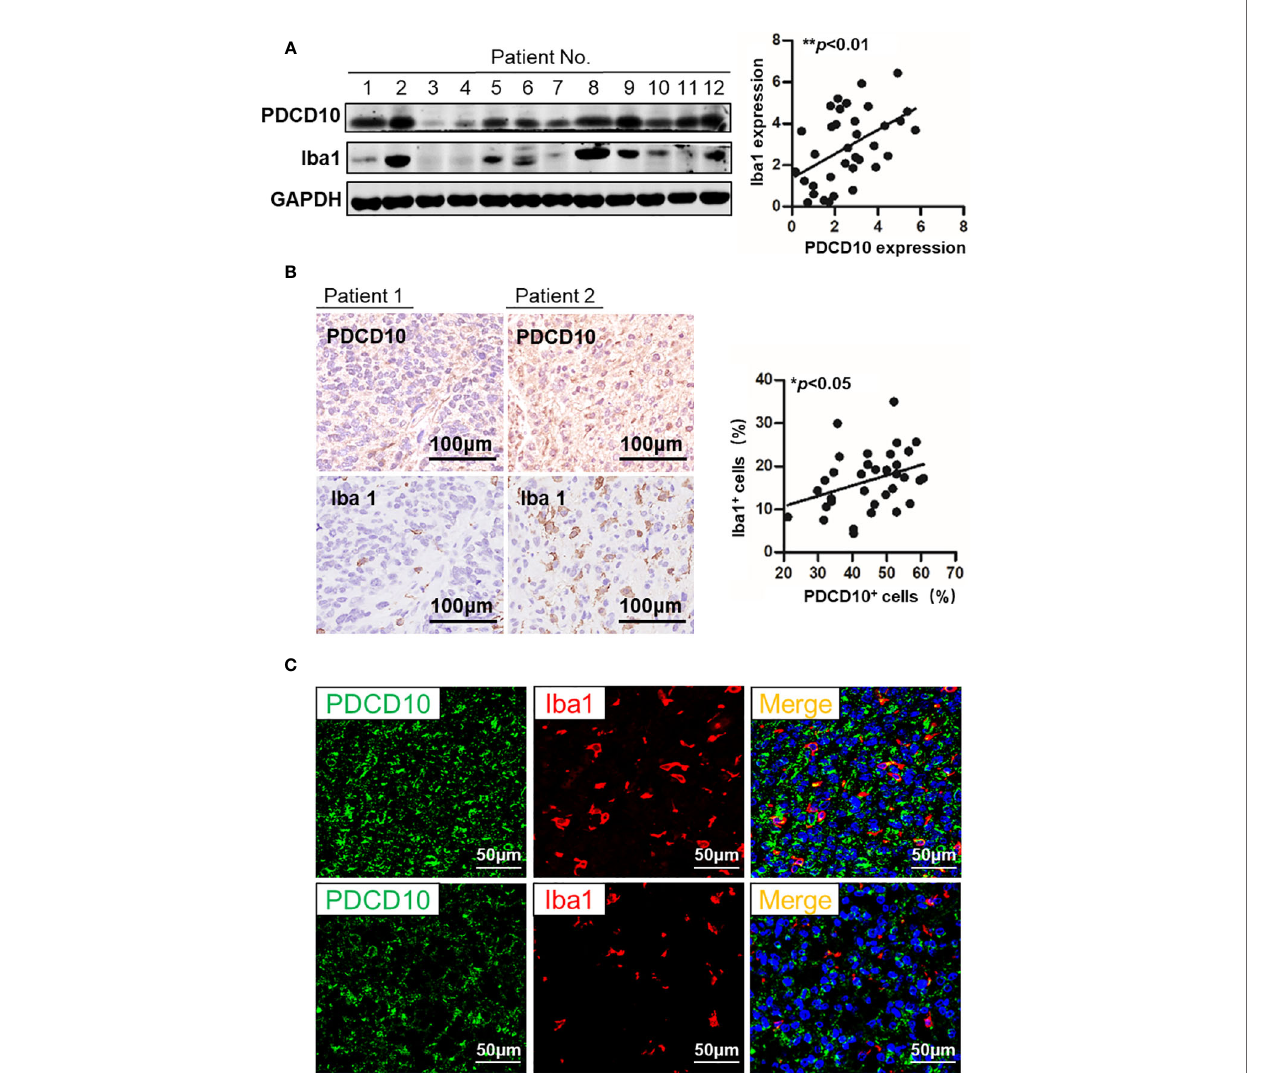
FIGURE 1 | The expression of PDCD10 in glioblastoma (GBM) patients displayed a positive correlation with the in fi ltration of glioma-associated microglia/ macrophages (GAMs). (A) Western blot of PDCD10 and Iba1 in GBM patients. Representative blots showed the expression of PDCD10 and Iba1 in GBM patients. Semi-quanti fi cation of the blots revealed a positive correlation between PDCD10 and Iba1 expression. (B) Immunohistochemical staining of PDCD10 and Iba1 on the adjacent sections of GBM patients. Quantitative analysis revealed that the number of GAMs was positively correlated with that of PDCD10-positive staining cells. (C) Immuno fl uorescent staining of PDCD10 and Iba1 in representative GBM patient. The altered immunoreactivity of PDCD10 (left panel) and Iba-1 (middle panel) were identi fi ed in various tumor regions. As shown in double staining (right panel), a massive number of Iba1-labelled GAMs (red) was observed in high PDCD10- immunoreactivity (green) areas. *p< 0.05; **p<